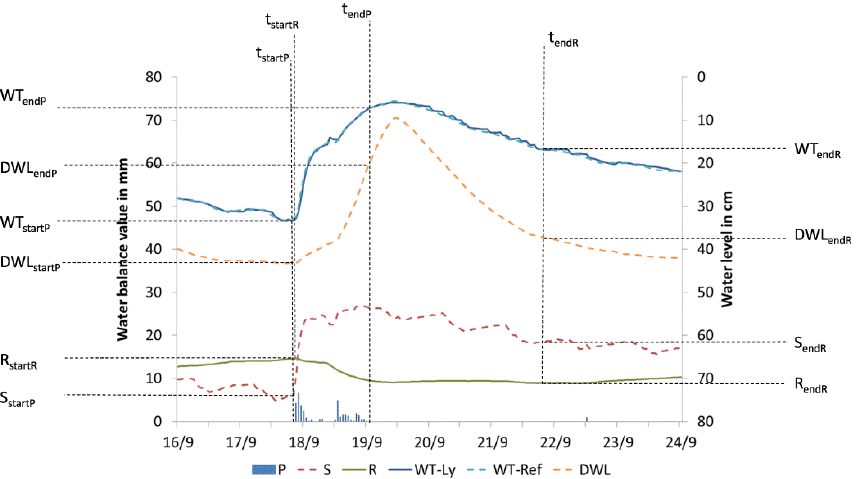
Figure 2. Illustration of variables determined for each rainfall event (WT—water table below surface, DWL—ditch water level (adjusted to surface elevation of WT measurement point), DWL—ditch water level (adjusted to surface elevation of WT measurement point), P—precipitation, R—cumulated outflow/inflow, S—water storage, t—time, Ly—lysimeter, Ref—reference station).